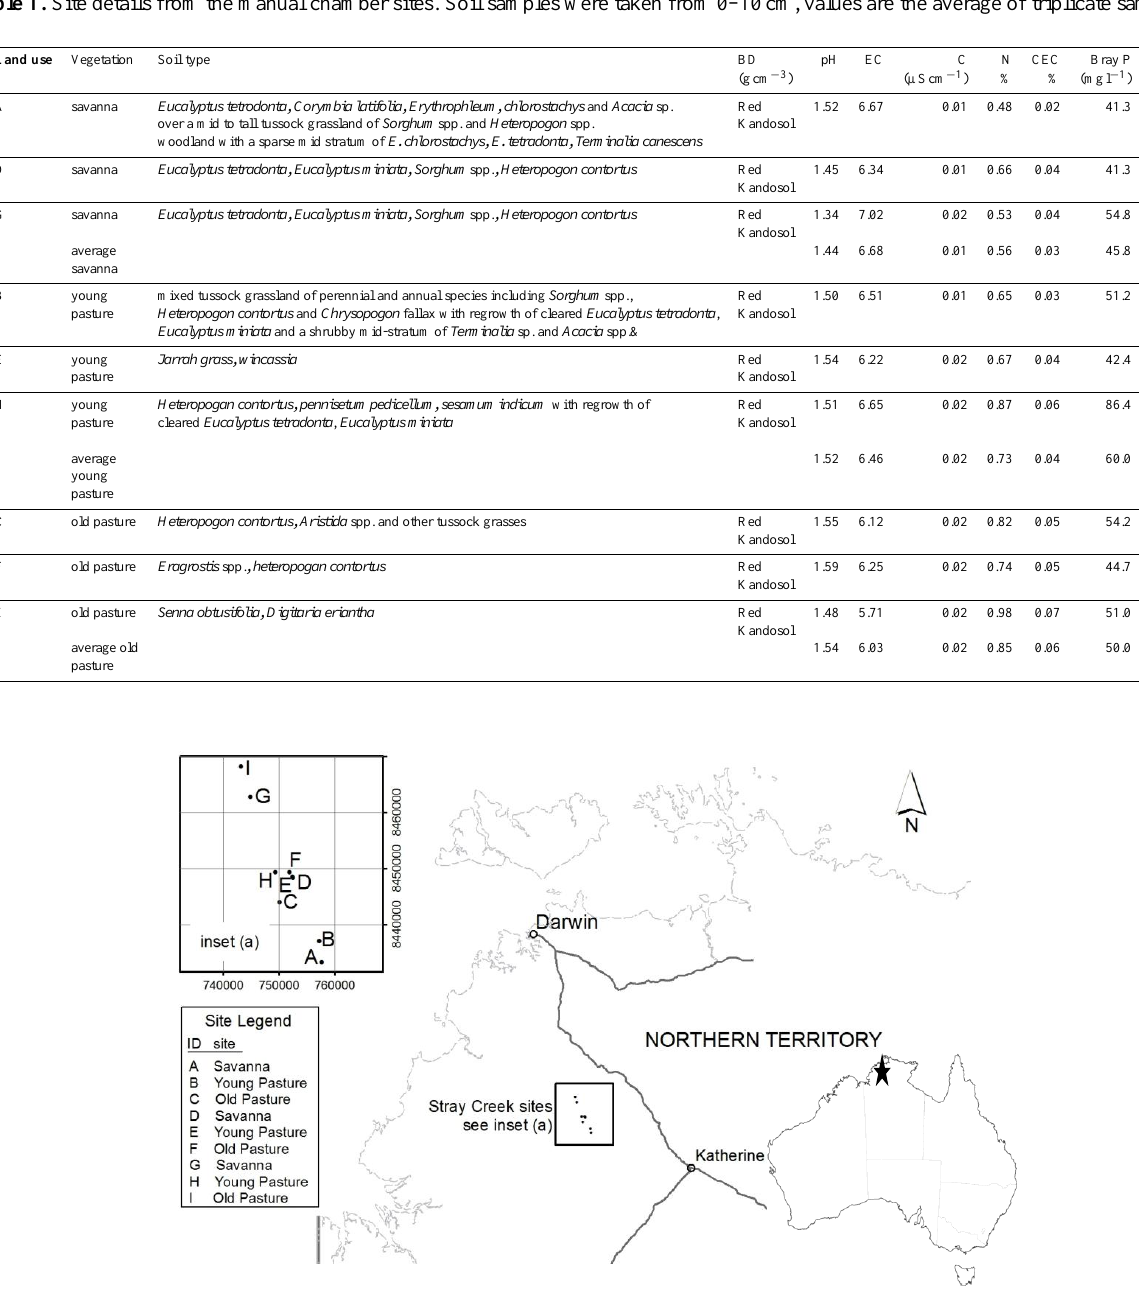
Fig. 1. Regional map of the Douglas-Daly region in the Northern Territory of Australia, showing the locality of the nine field sites; three savanna woodlands, three young pastures and three old pastures. The star shows the location on the continental map of